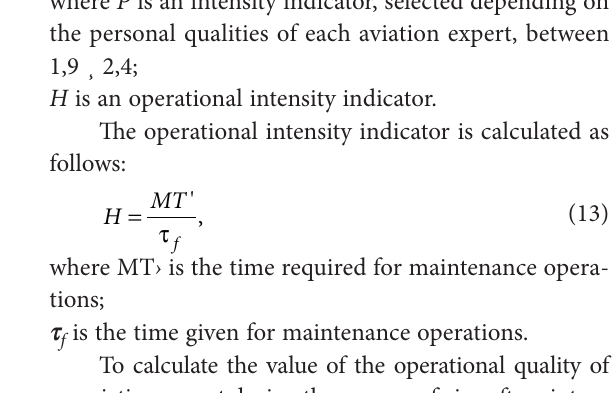
Development of operational